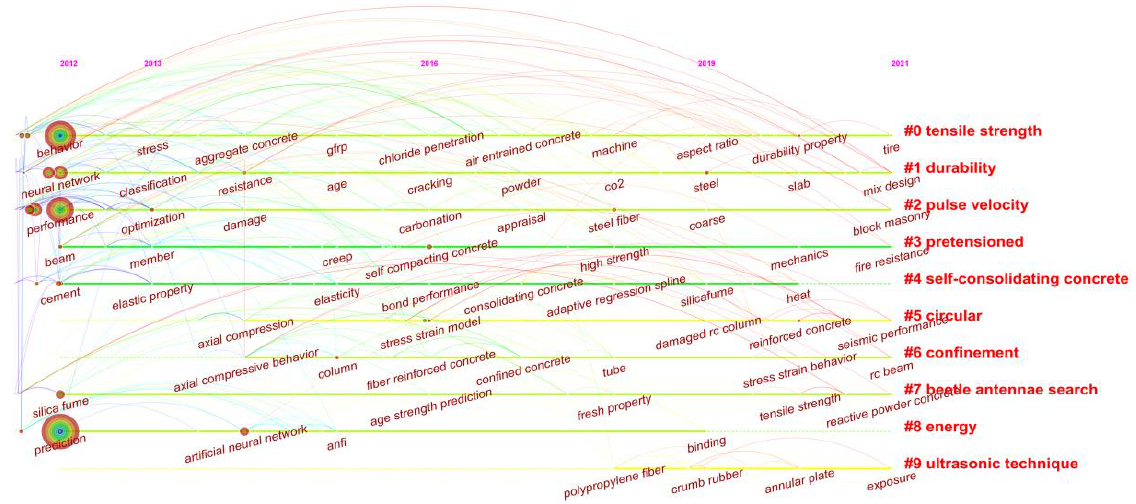
Figure 8. Timeline view of hot research areas.